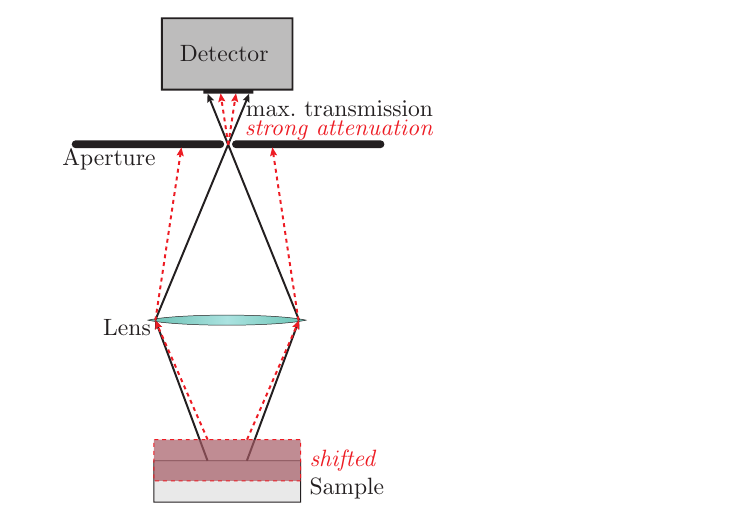
Figure 5. Detected luminance for two different sample positions. Black: ideal position, red: